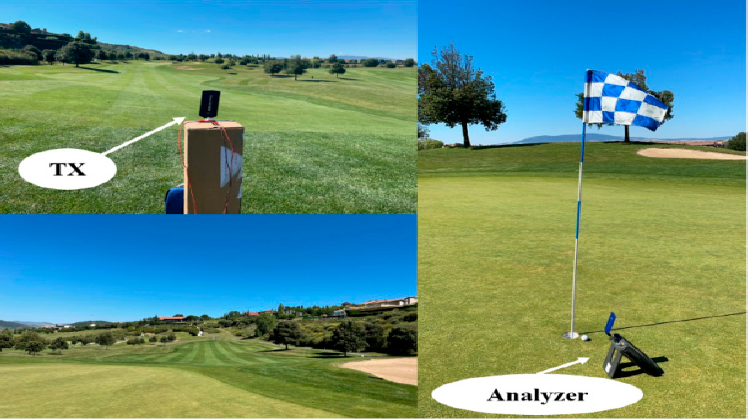
Figure 5. View of Hole 1 and the measurements setup.